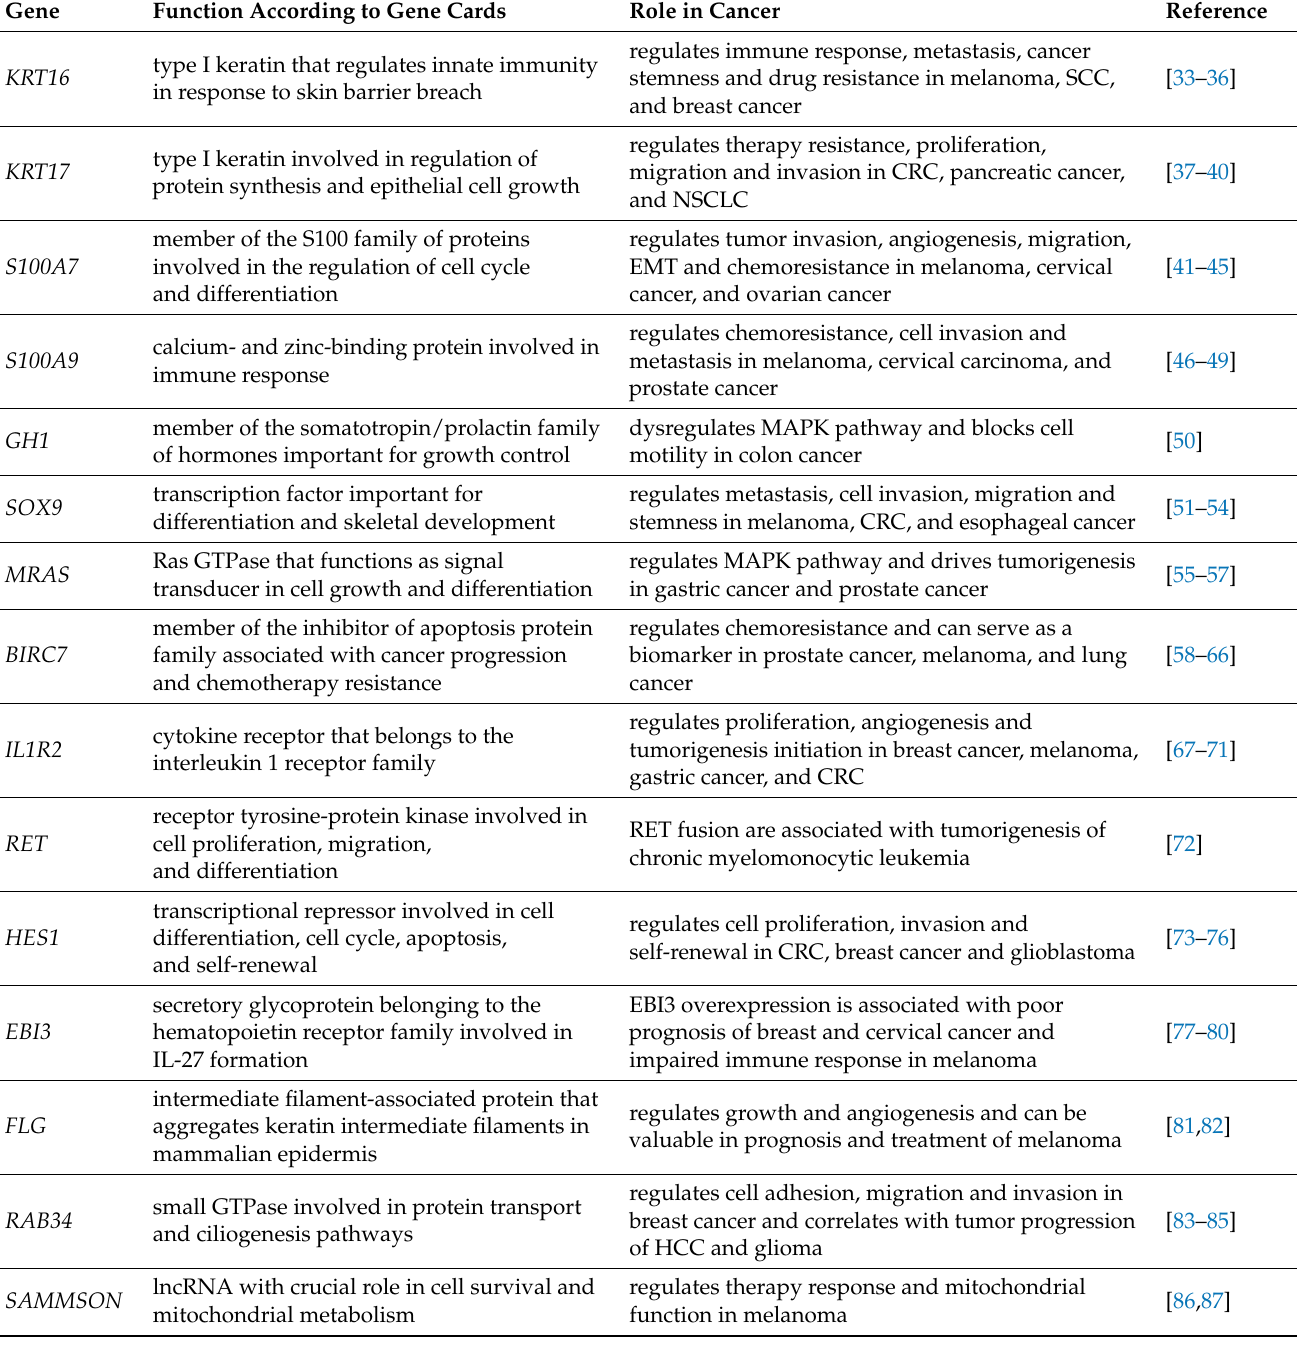
Table 1. Summary of known functions and roles of 21 selected GLI target genes in